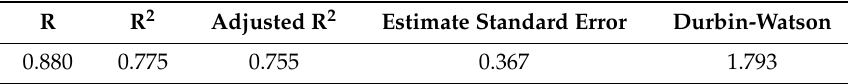
Table 5. Model summary indicators.